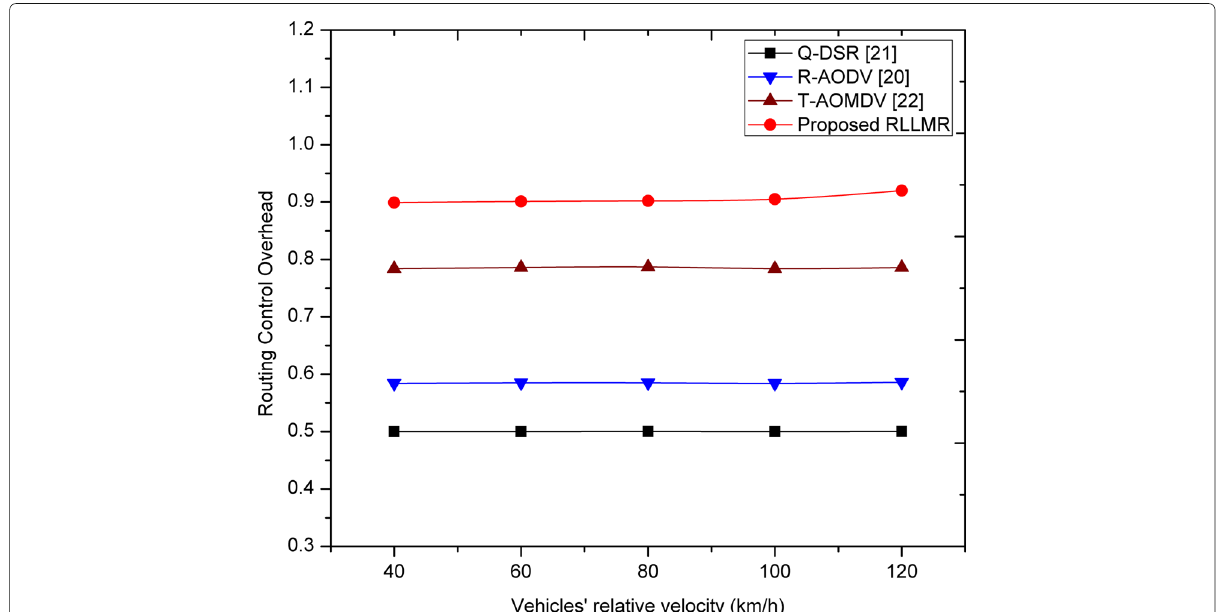
Fig. 17 Effect of different velocities over routing overhead (nodes 50, R 1000 m, sig 5 km/h, t 10